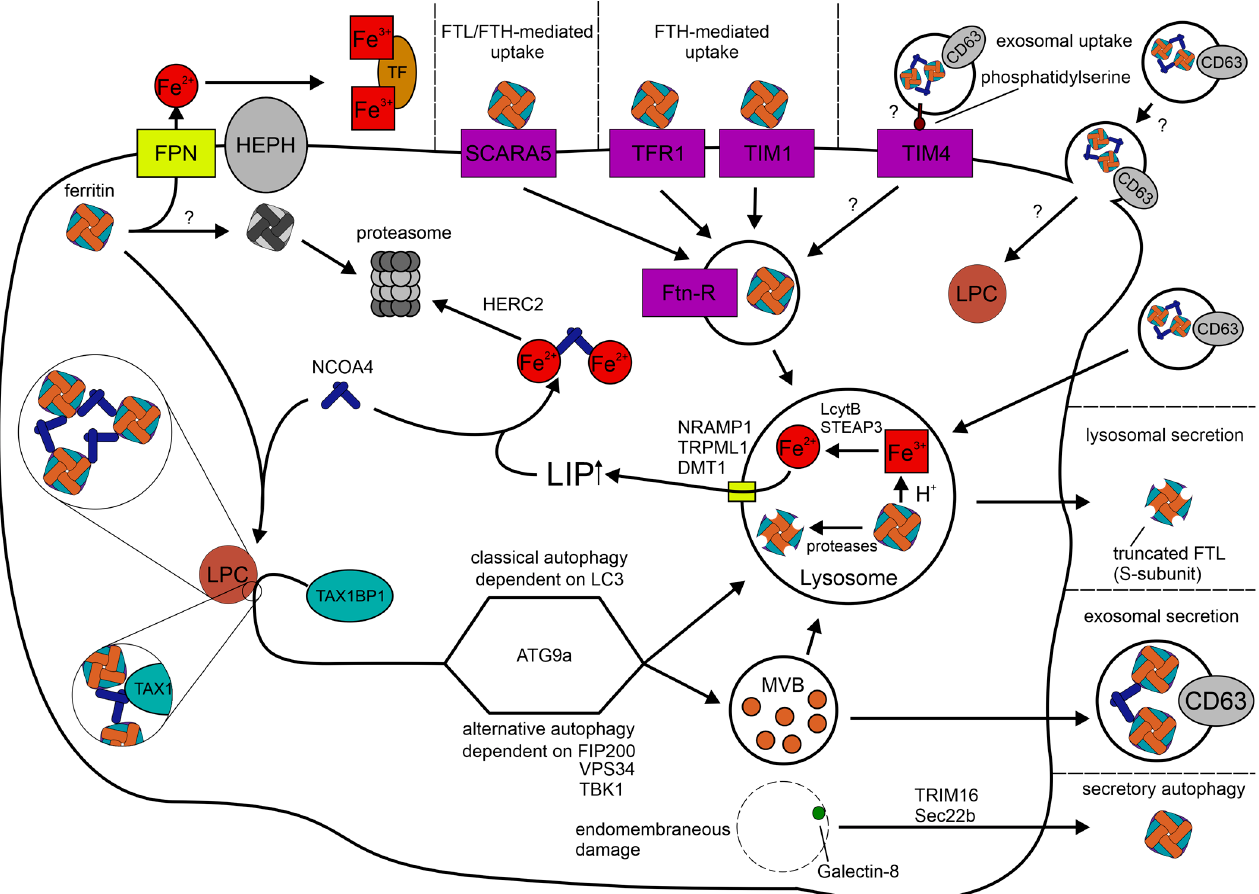
Figure 2. Schematic depiction of ferritin metabolism and trafficking in a hypothetical human cell. Known and putative receptors involved in ferritin uptake are marked in violet. SCARA5 is also representative for SCARA1 and SCARA2, which have a lower affinity for ferritin. Ferrous iron transporters are marked in yellow. Ferritin uptake mechanisms are depicted on the top right and mechanisms for ferritin secretion are shown on the right. Inside the cell, the process of ferritinophagy, which is the trafficking of ferritin to the lysosome and subsequent iron release from ferritin, as well as the FPN mediated proteasomal degradation are depicted. Hitherto unknown or unresolved mechanisms are highlighted with a question mark. FPN: ferroportin-1, NCOA4: nuclear receptor